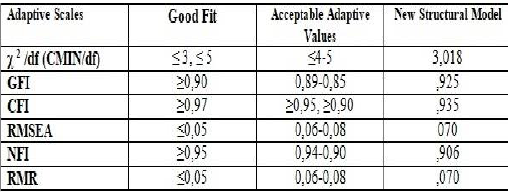
Table 5 indicates values such as χ2: Ki square